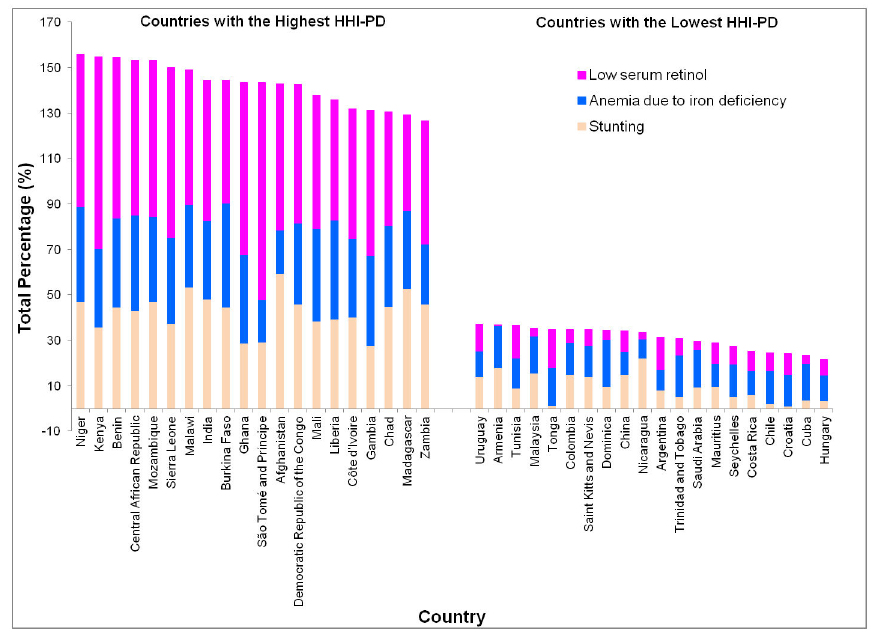
Figure 1. Prevalence of stunting, iron deficiency anemia, and low serum retinol in the countries with the 20 highest and lowest hidden hunger index based on the prevalence estimates (HHI-PD). The hidden hunger index (HHI-PD) was estimated based on national estimates of the prevalence of stunting, anemia due to iron deficiency, and low serum retinol